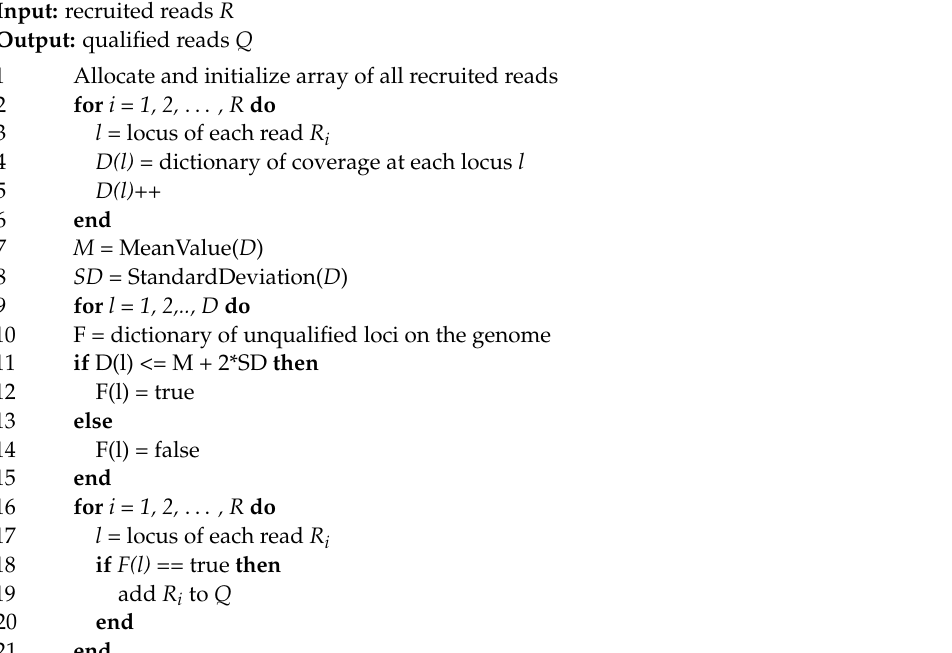
Algorithm 1: Filter Recruited Reads that Are Located at Highly Covered